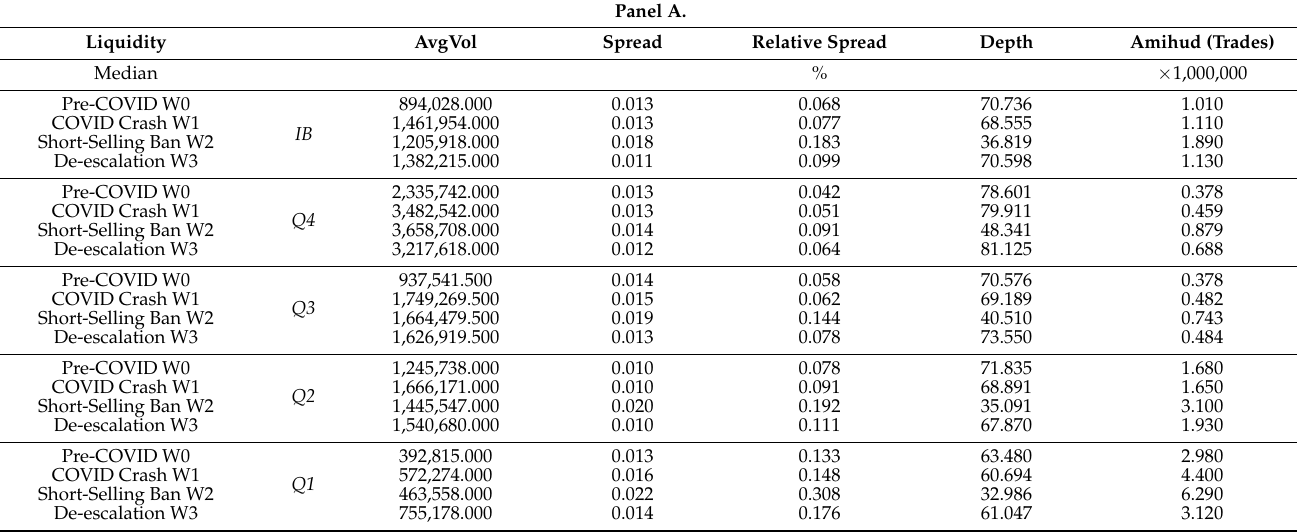
Table 2. Panel A. Liquidity measures. Panel B. Changes in median: liquidity measures. Panel